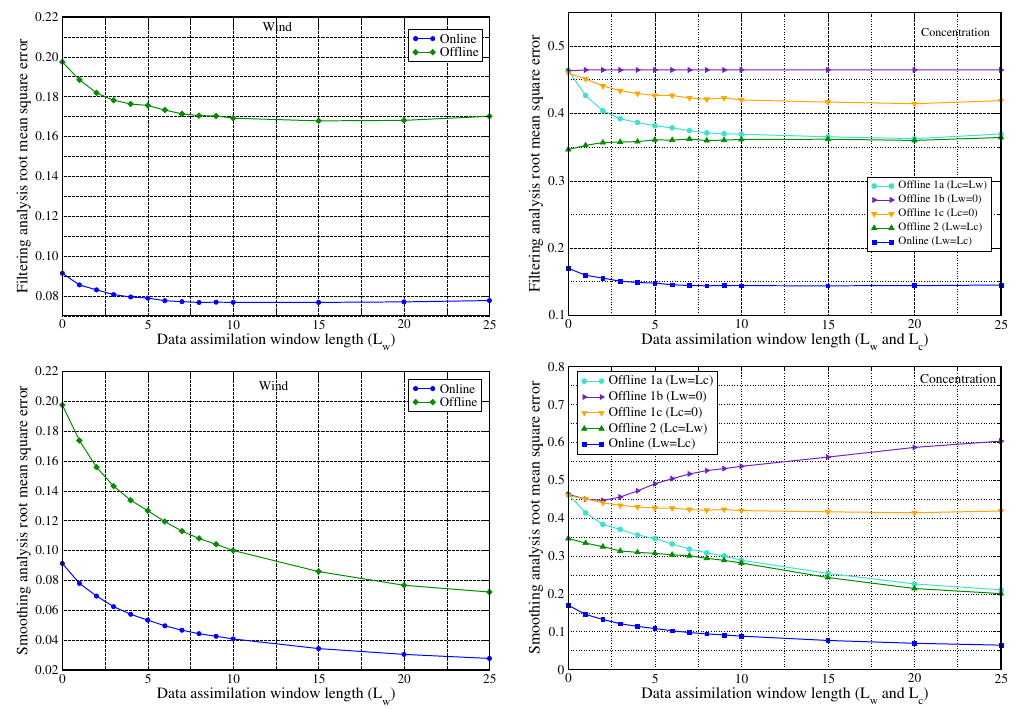
Figure 5. Average RMSEs of the L95-T data assimilation system using the IEnKS, as a function of the DAW length (in units of (cid:49)t = 0 . 05 of the L95 model). The two top panels show the filtering RMSEs, while the two bottom panels show the smoothing RMSEs. The scores of the wind variables are on the left, while scores of the concentration variables are on the right. The case L = 0 corresponds to the ensemble transform EnKF.